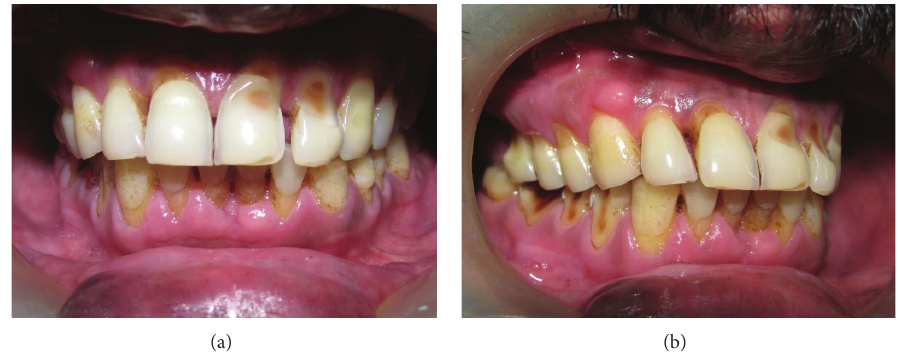
Figure 2: (a) Postoperative view (2 months after drug substitution). (b) Postoperative view (2 months after drug